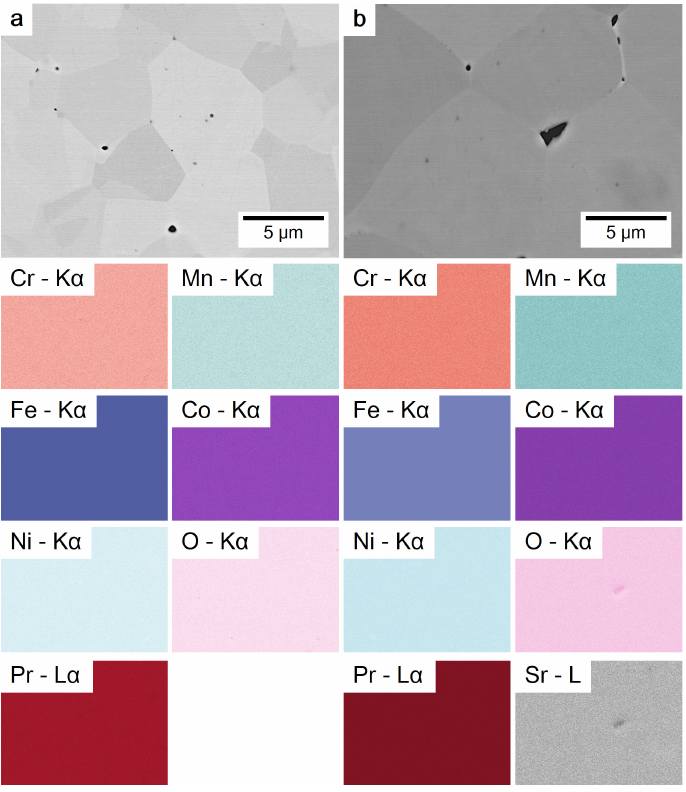
Figure 5. Electron channeling contrast images of vibratory-polished cross-sections of membranes ( a ) Pr(Cr,Mn,Fe,Co,Ni)O 3– δ and ( b ) Pr 0.5 Sr 0.5 (Cr,Mn,Fe,Co,Ni)O 3– δ and corresponding elemental distributions derived from silicon drift